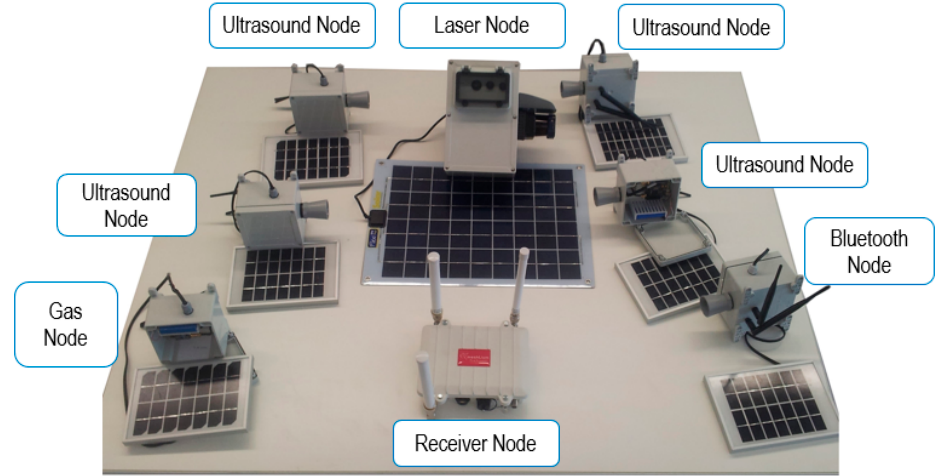
Figure 2. Different types of nodes developed for the Urban Information System.